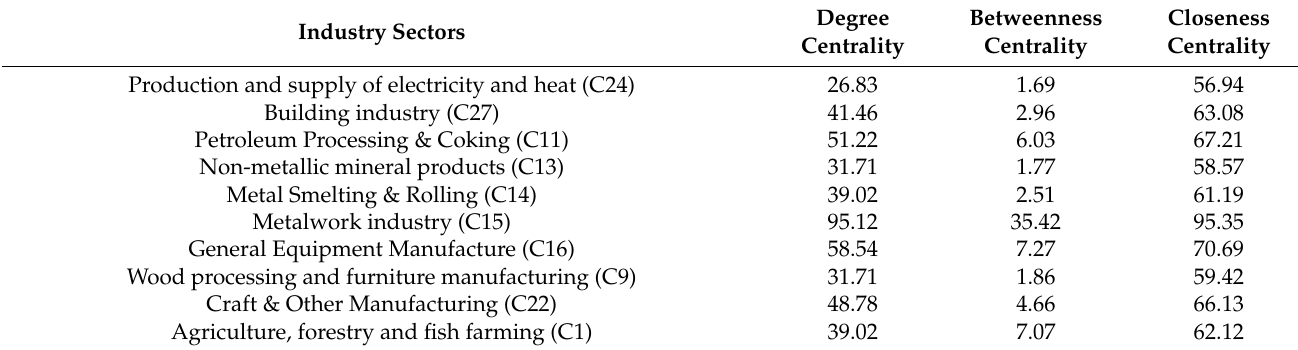
Table 5. Distribution of the values of centrality of 10 industrial sectors in Heilongjiang Province in